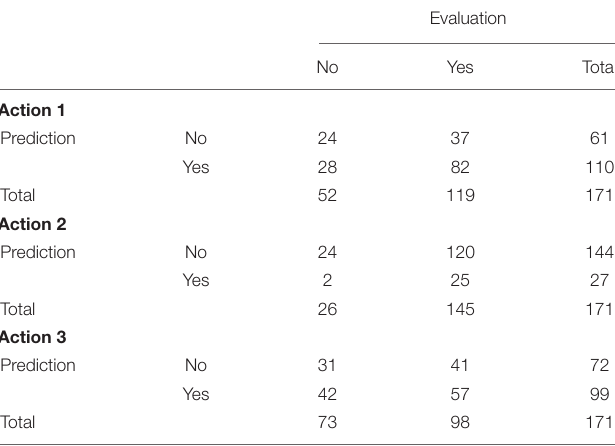
TABLE 1 | Frequencies of predictions and evaluations that were conjectured to drive switching between the actions concept selection and conceptual combination and idea generation (action 1), concept selection (and the repetition thereof) (action 2), and conceptual combination and idea generation (and the repetition thereof) (action 3).